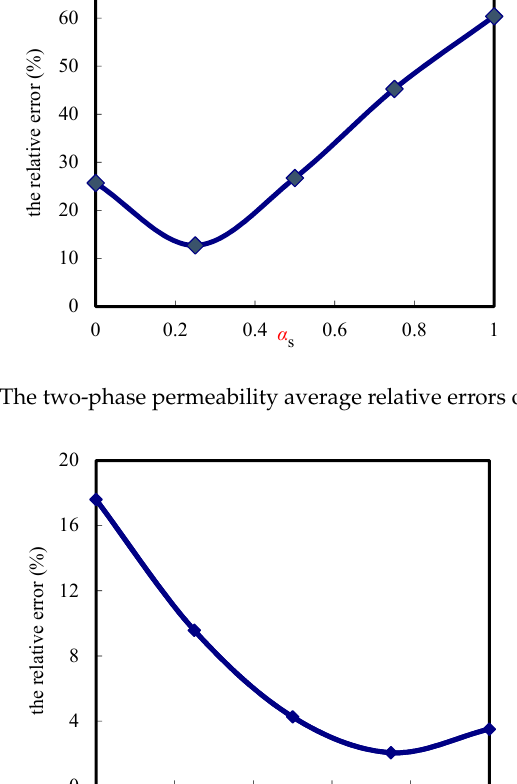
Figure 10. The two-phase permeability average relative errors of core 69 # .